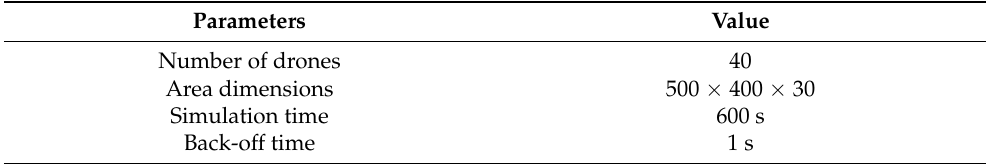
Table 1. Simulation parameters for the